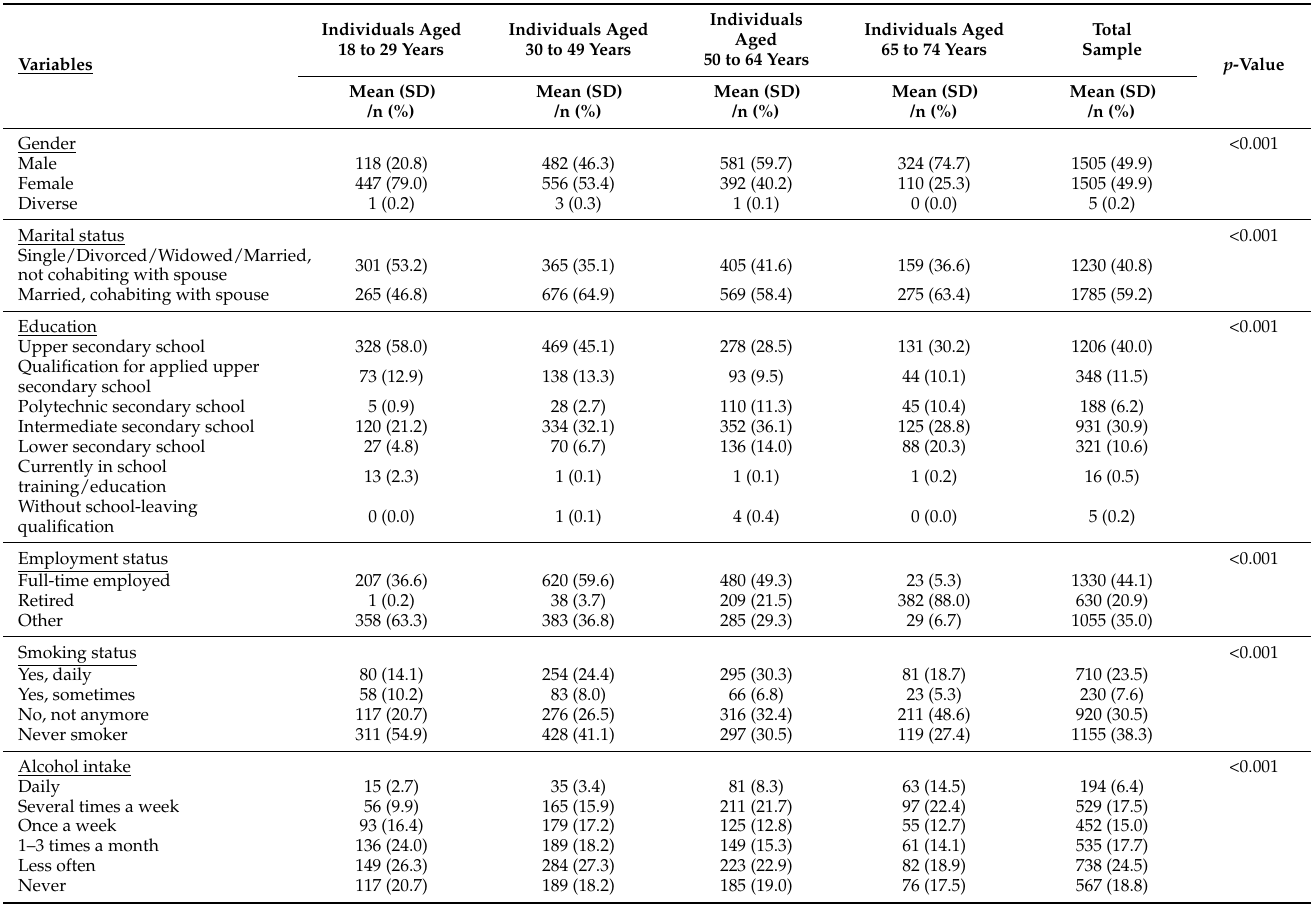
Table 1. Sample characteristics for the analytical sample (total sample and for the different age